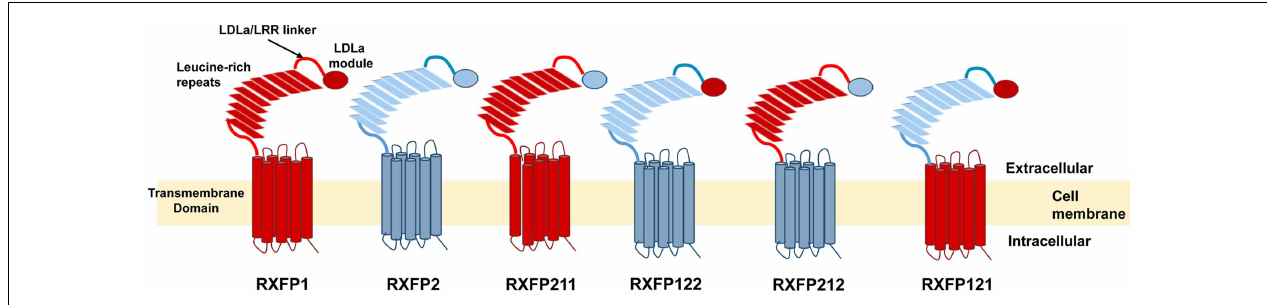
FIGURE 2 | Schematic representation of the RXFP1 and RXFP2 receptors compared to the RXFP211, RXFP122, RXFP212, and RXFP121 chimeric receptors .The domains of receptors are labeled on the RXFP1 receptor. RXFP1 domains are in blue while RXFP2 domains are in red.